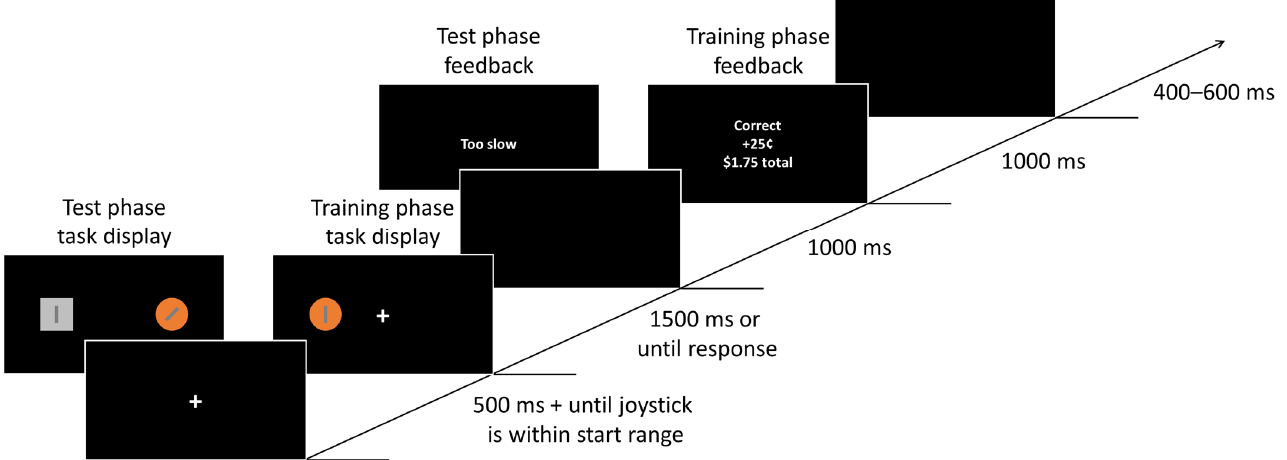
Figure 1. In Experiment 1, the sequence of trial events was identical for the training and test phases, except that, during the training phase, the task display only contained a target circle, and feedback was always provided (“Correct” or “Incorrect”), together with outcome delivery. During the test phase, the task display contained a target square and a distractor circle, one on each side. Feedback was provided only when participants made an incorrect response (“Incorrect”) or failed to make a response in time (“Too slow”).